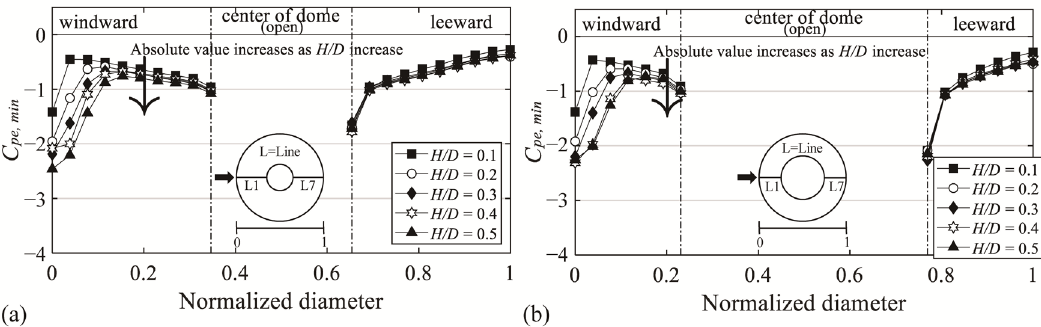
Figure 9. Variation of C pe, min depending on H/D of the central open dome: ( a ) open ratio = 30% and ( b ) open ratio = 50%.